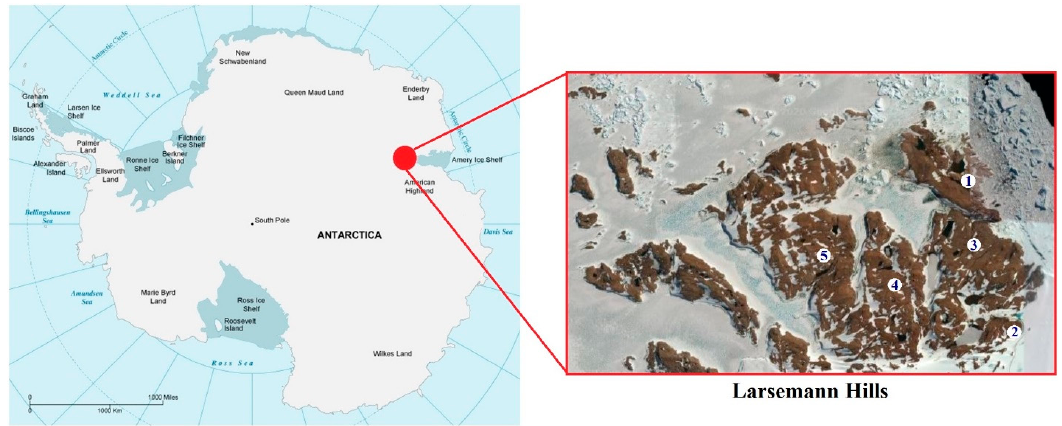
Figure 1. Map of the study area. Anthropogenically-affected sites: 1—Progress 1; 2—Progress 2.